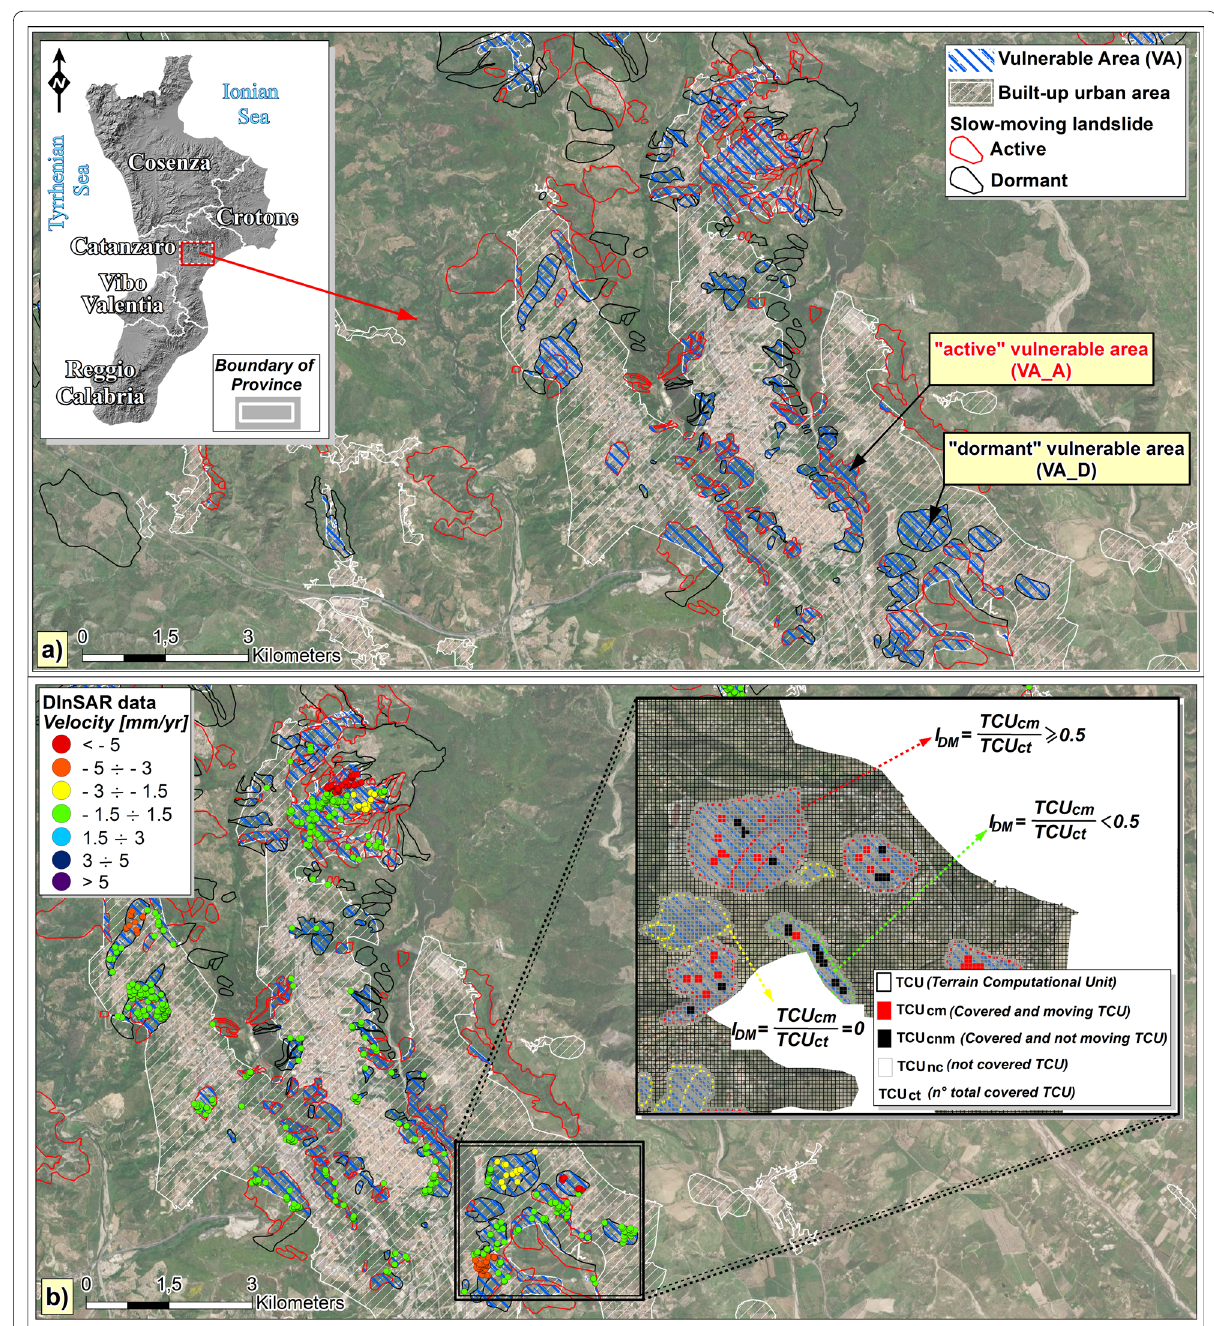
Fig. 7 Examples of vulnerable areas (VAs) deriving from the intersection of the slow-moving landslide (SML) inventory map and the built-up urban area (UA) map with indication of a “ active ” (VA_A) or “ dormant ” (VA_D) vulnerable areas distinguished according to the landslide state of activity and b possible values assumed by the Index of DInSAR-based movement (I DM